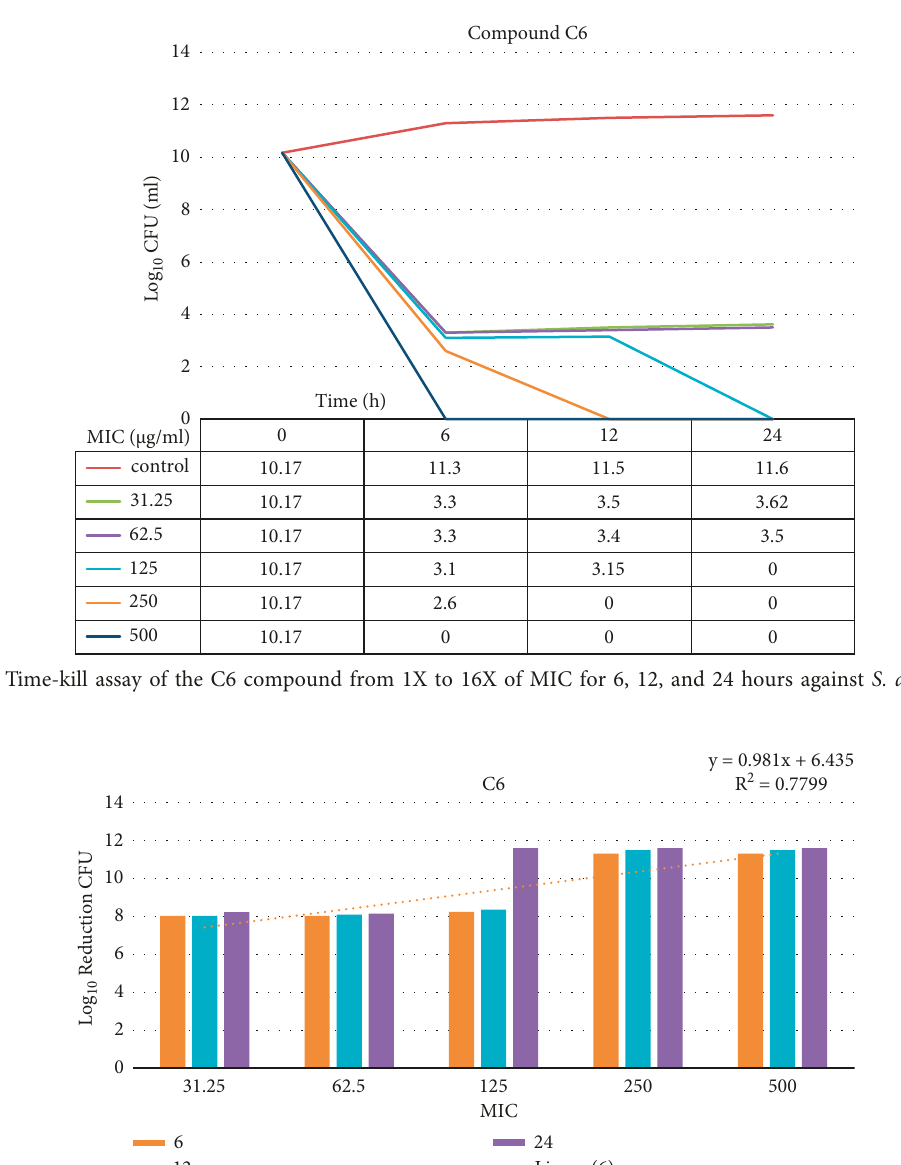
Figure 12: IC50 of the C6 compound from 1X to 16X of MIC for 6, 12, and 24 hours against S. aureus